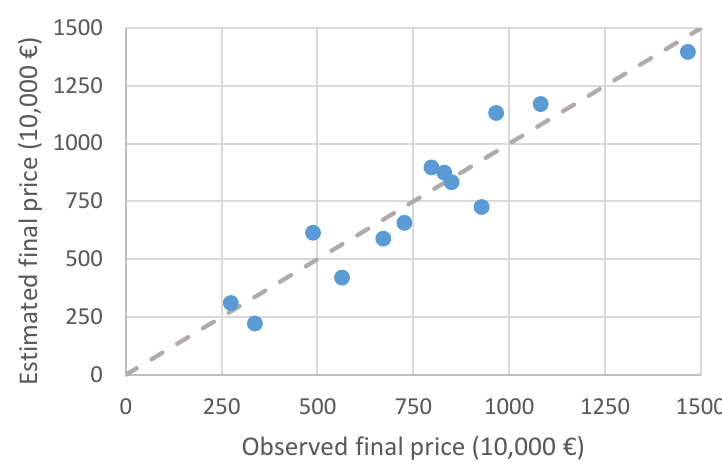
Figure 2. Observed versus estimated total cost and initial and final price.